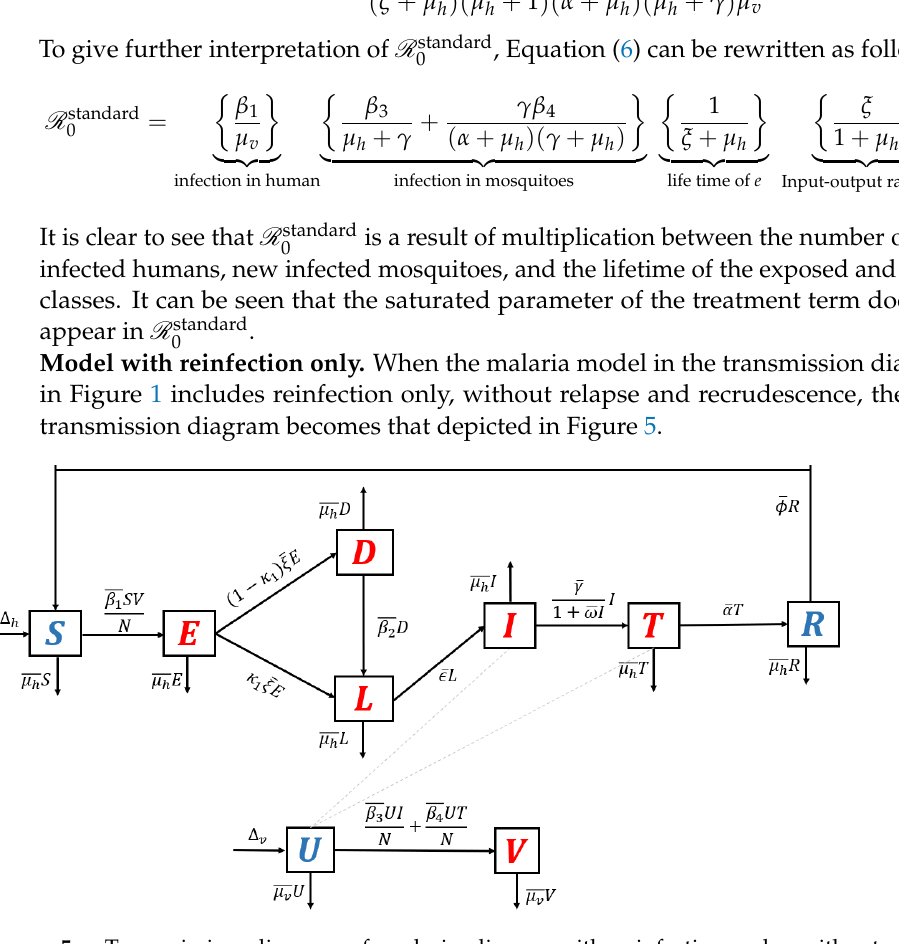
Figure 5. Transmission diagram of malaria disease with reinfection only, without relapse and